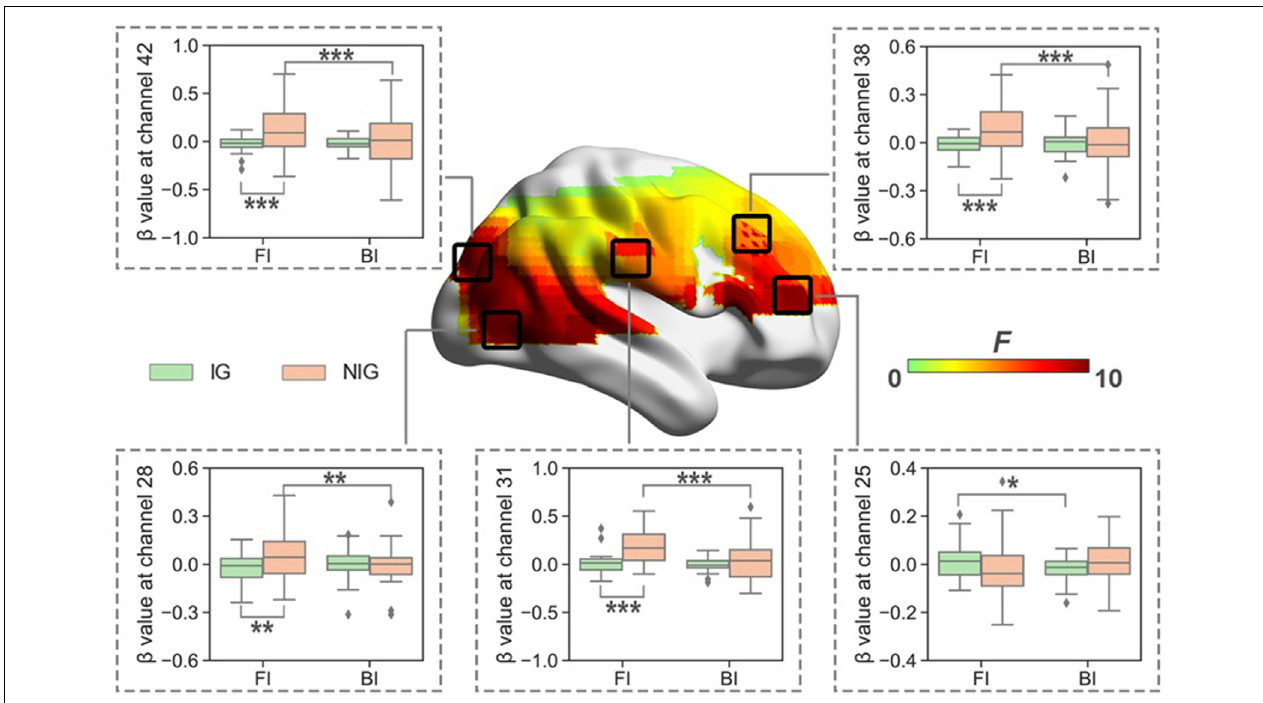
FIGURE 5 | The heat map corresponding to the activated channels impacted by the interaction between interpreting direction and interpreting expertise in HbO, when normalized for reading; the average β value for such interaction in the activated channels. * p < 0.05; ** p < 0.01; *** p < 0.001. Error bars represent minimum/maximum values. The diamond dots mean extreme values. The shaded area indicates the 95% confidence